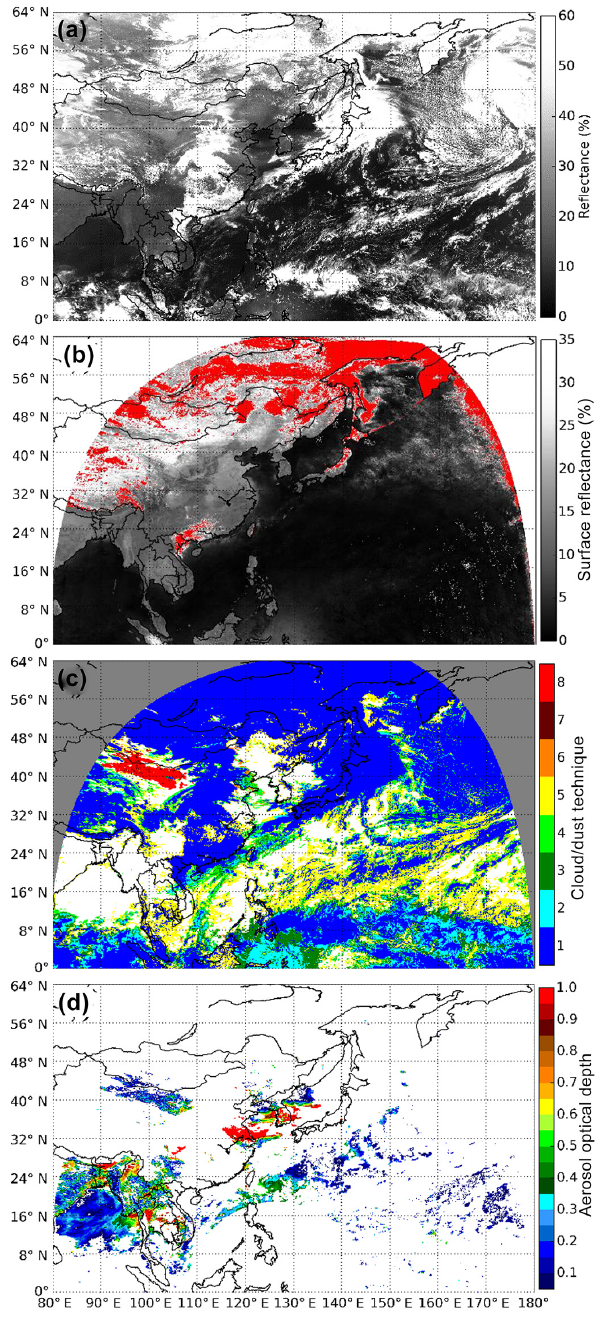
Figure 2. All panels pertain to 18 March 2014 at 05:00UTC. (a) MTSAT-2 imager 0.68µm reflectance scan. (b) R sfc retrievals for each valid pixel in MTSAT-2 imager scan where pixels with R sfc >35% are denoted in red. (c) Cloud/dust detection results where the color bar labels relate to technique no. in Table 3. (d) MTSAT AOD